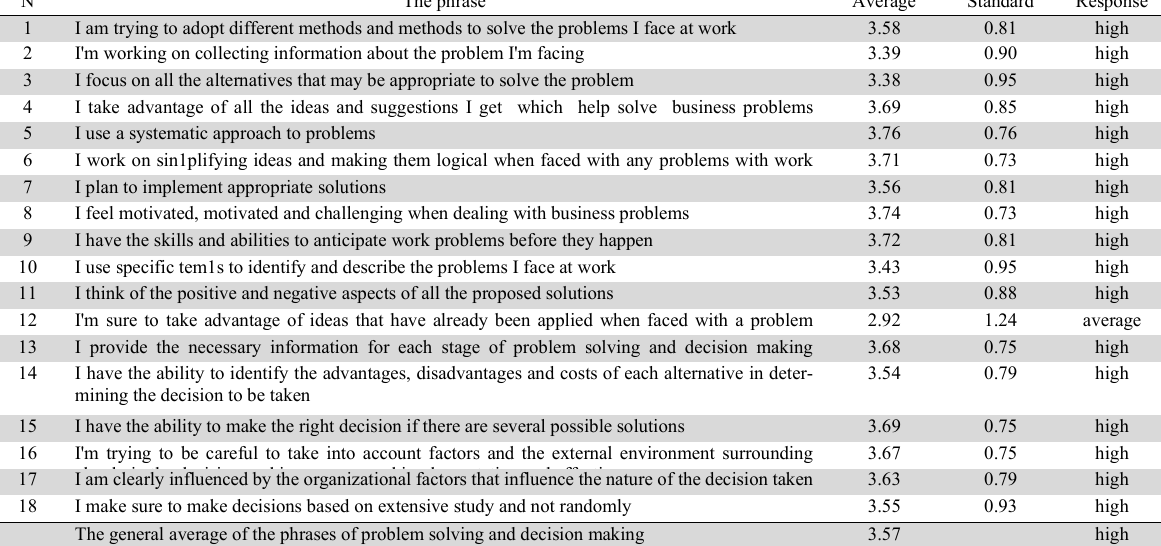
Arithmetical averages and standard deviations of problem solving and decision making N The phrase Average